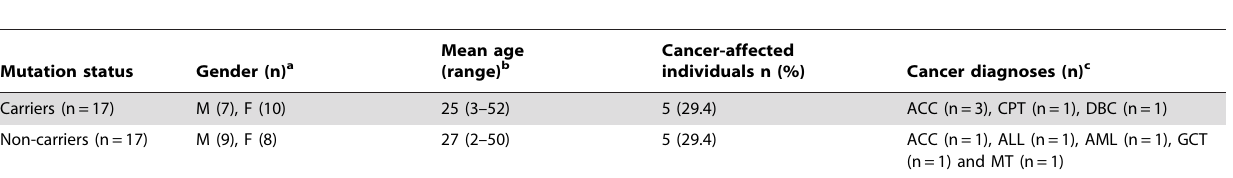
Table 1. Gender, mean age and number of individuals with cancer diagnosis among TP53 p.R337H mutation carriers and non- carriers.